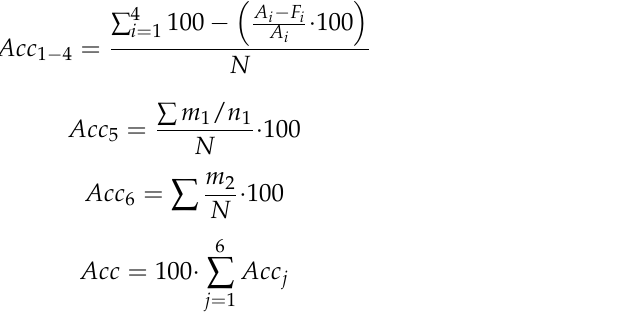
Table 2. Accuracy within a sample of 80 results. Description